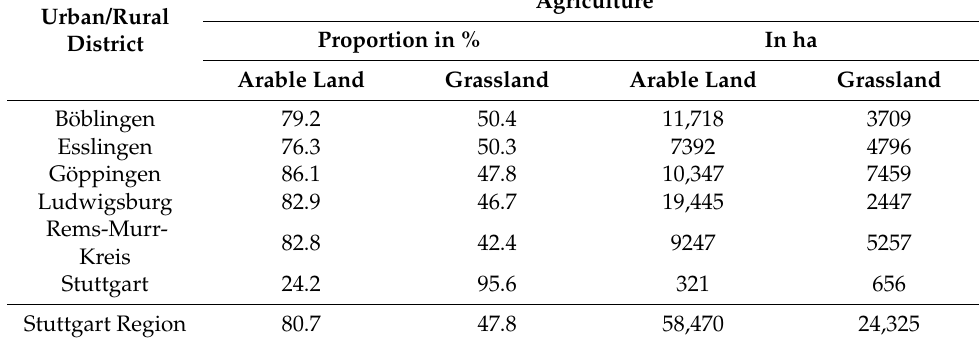
Table 8. Proportion of arable land and grassland in % and in ha that is suitable for the implementation of PIC from the perspective of agriculture.